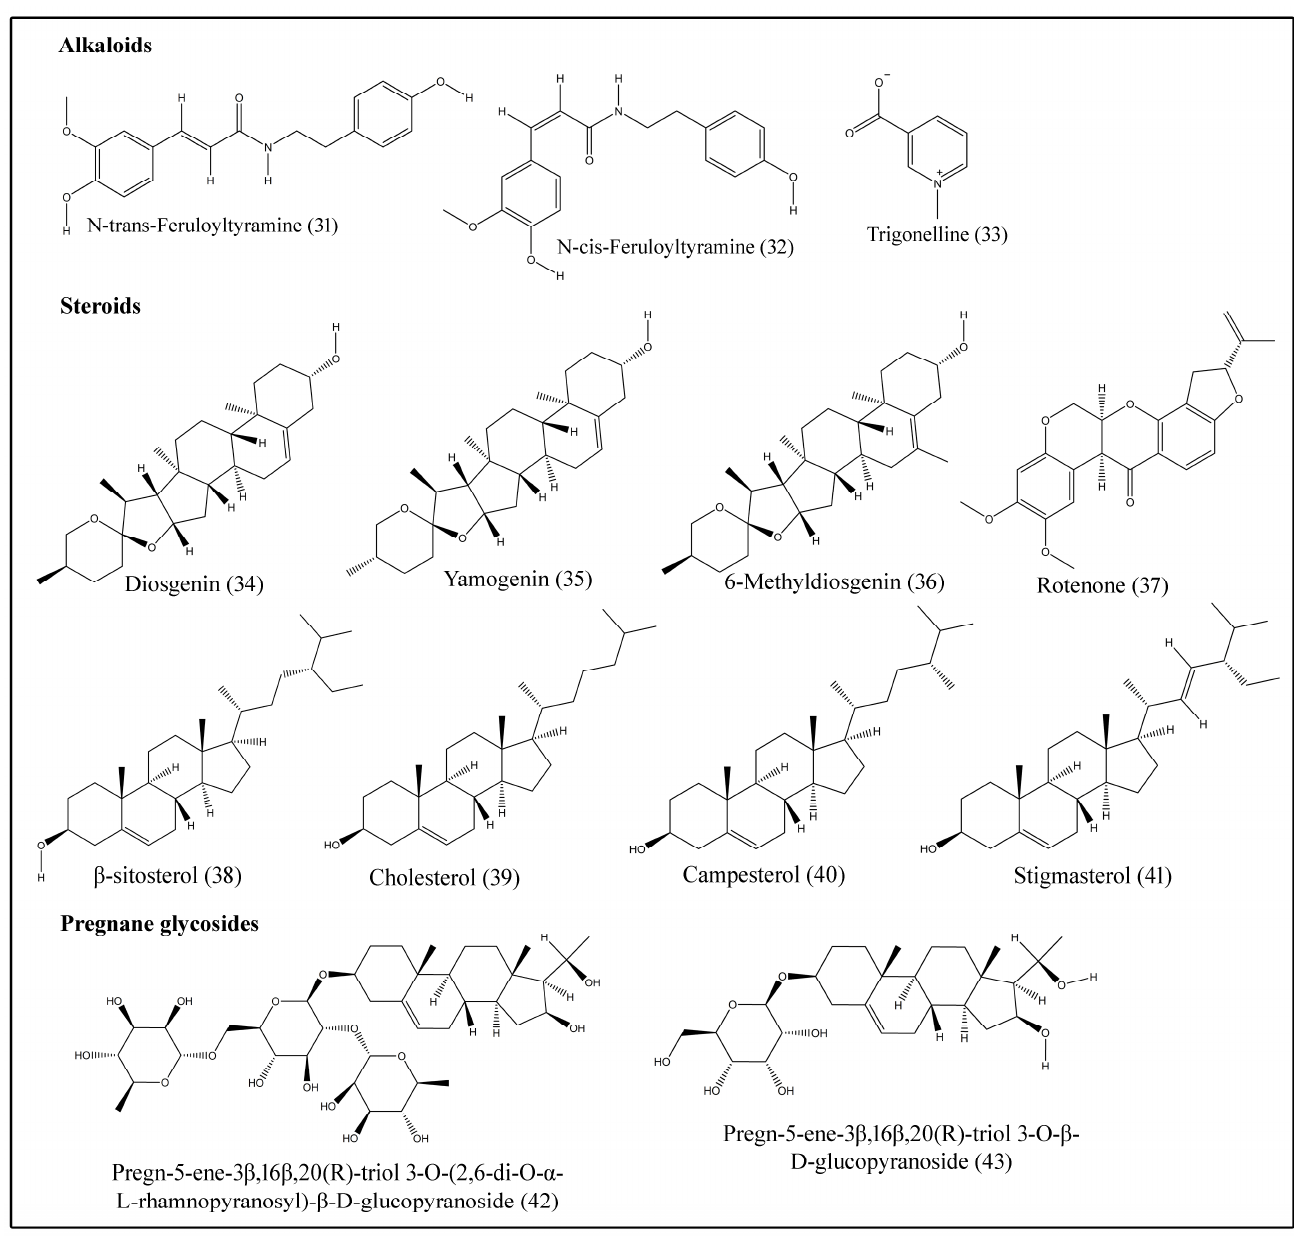
Figure 4. Structures of alkaloids, steroids and pregnane glycosides isolated from desert date. Pregnane glycosides are naturally occurring sugar conjugates of C 21 steroidal